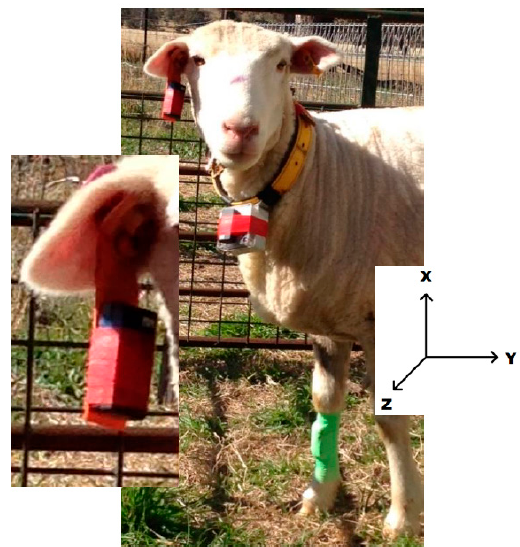
Figure 1. Experimental animal displaying the ear and neck (collar) locations evaluated. Insert shows the axis orientation of the sensor. Refer to Figure 3 for leg attachment display.